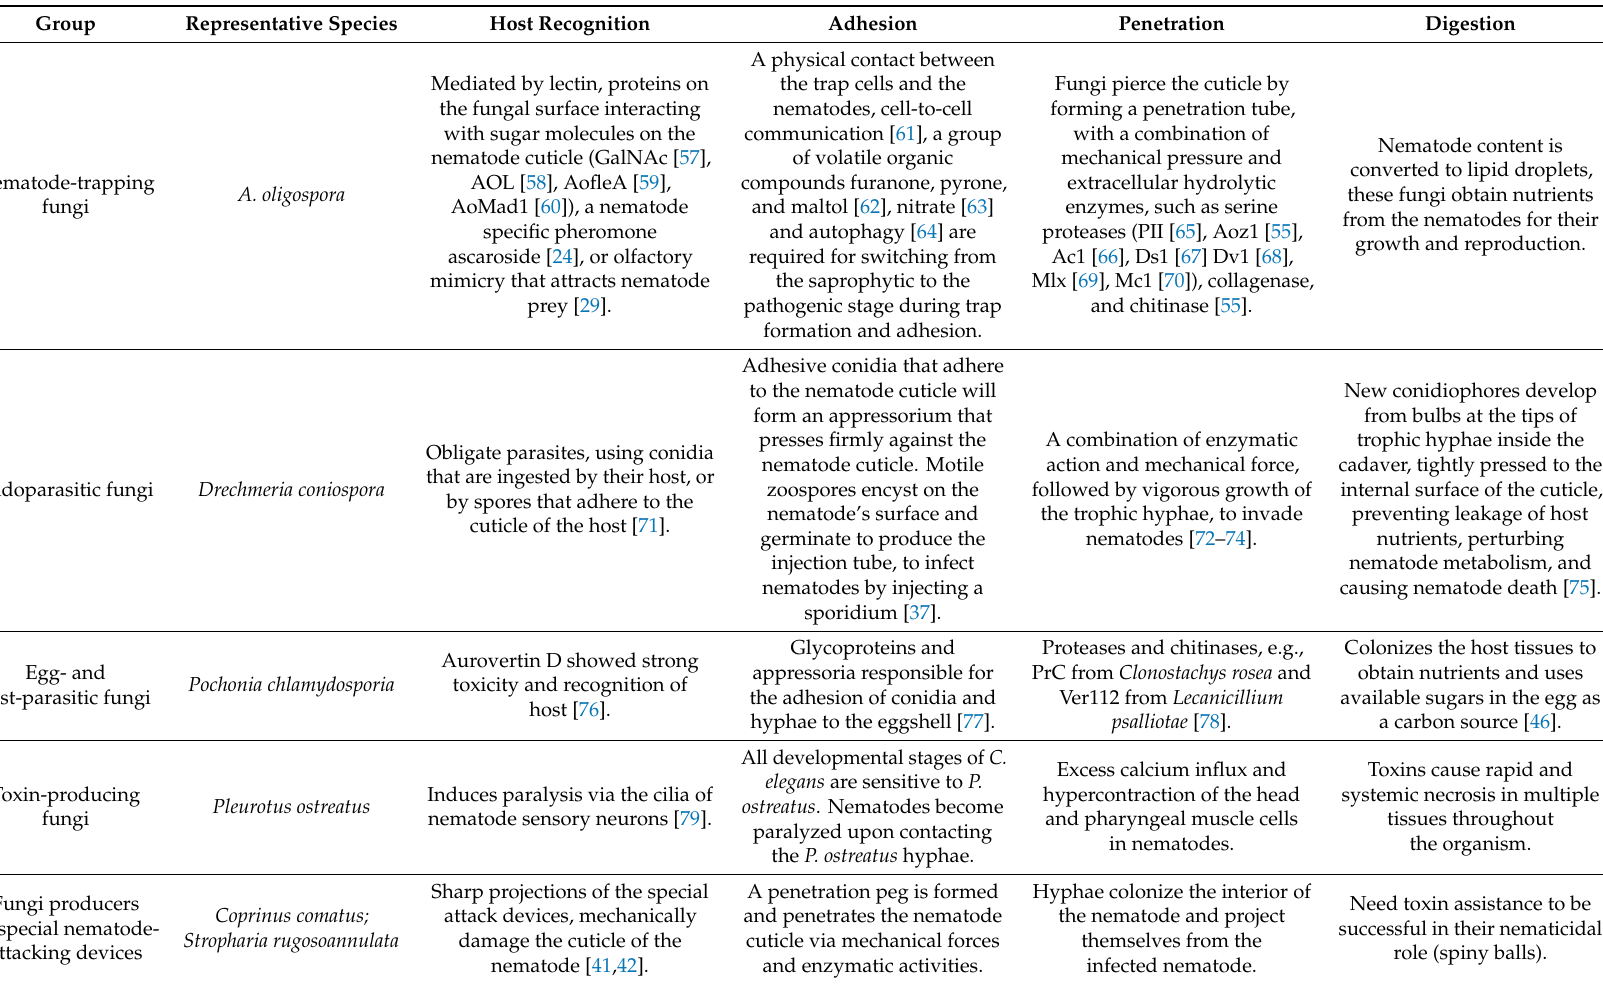
Table 1. Infection process of nematophagous